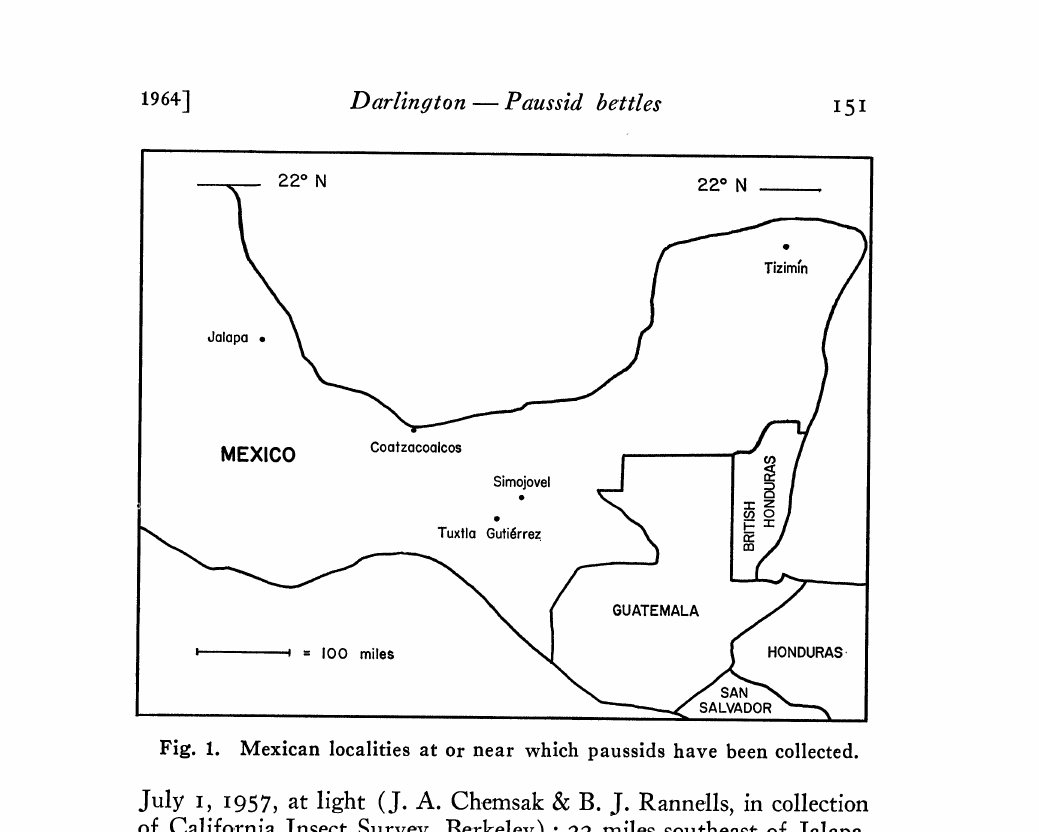
Fig. 1. Mexican localities at or near which paussids have been